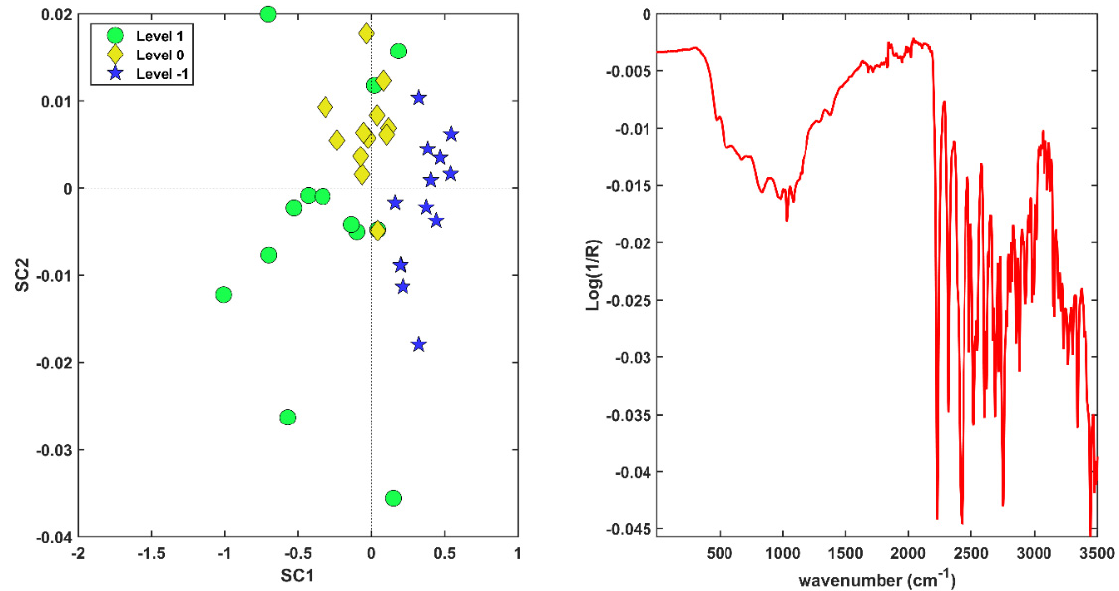
Figure 6. Scores ( left ) and loadings plot ( right ) associated to the ASCA model on effect pressure. Legend: pressure level 1: green dots; pressure level 0: yellow diamonds; pressure level -1: blue stars.